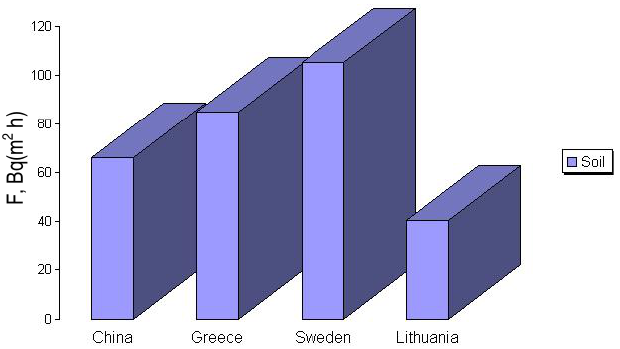
Fig 6 . Radon exhalation rate from the soil in Lithuania and other